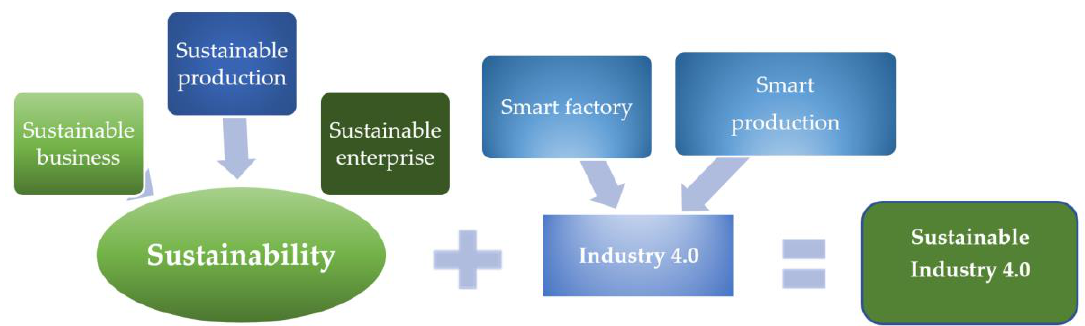
Figure 11. Subjects of the synthesis of bibliometric analysis: Sustainable Industry 4.0. Source: Own study based on bibliometric analysis.